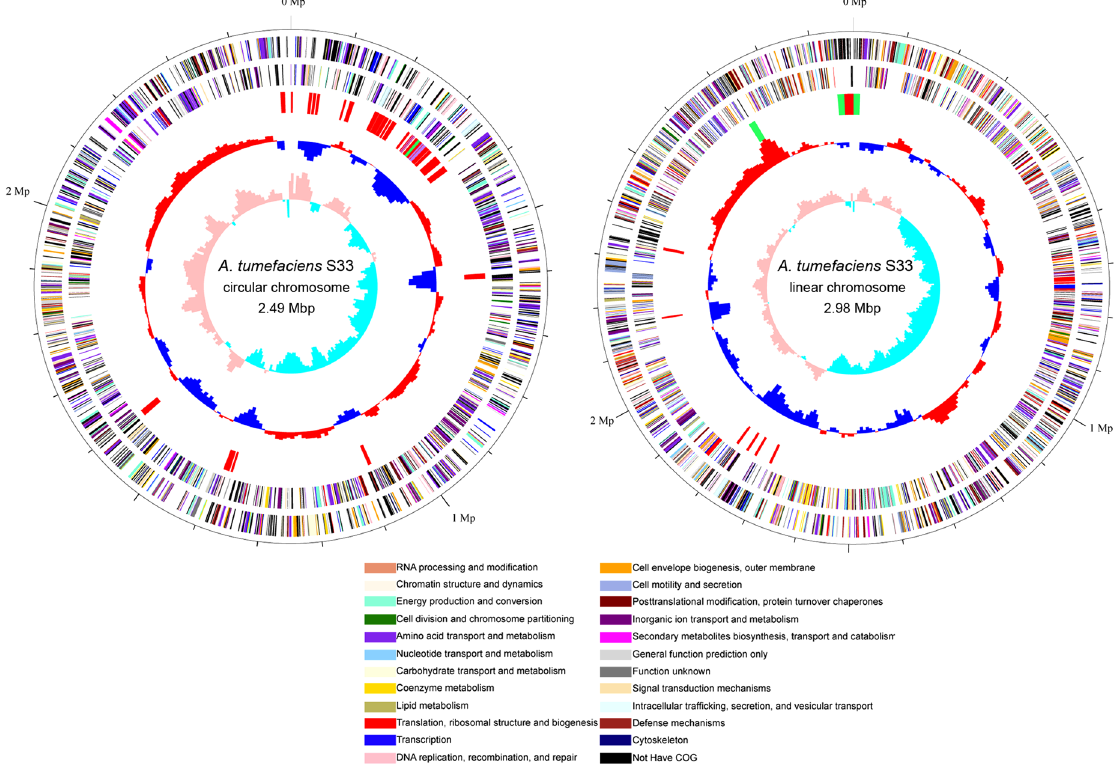
Figure 2. Circular representation of the circular chromosome (left) and linear chromosome (right) of A . tumefaciens S33. Outer two rings indicated genes encoded on the forward and reverse strands of the chromosome, respectively, analysed using the COG database (colours were assigned according to the colour code of the COG functional classes). The third circle indicates the predicted GIs (red), prophages (green) and the nicotine-degrading genes (purple). On the fourth ring, the deviation from the average G + C content is plotted. The most inner ring shows the value of the GC skew (G − C/G +